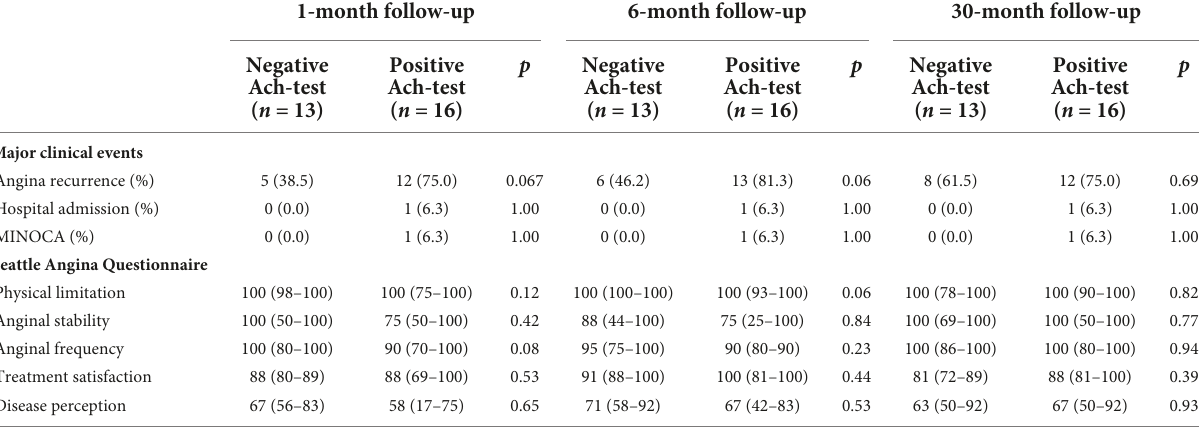
TABLE 4 Clinical outcomes of patients with positive and negative